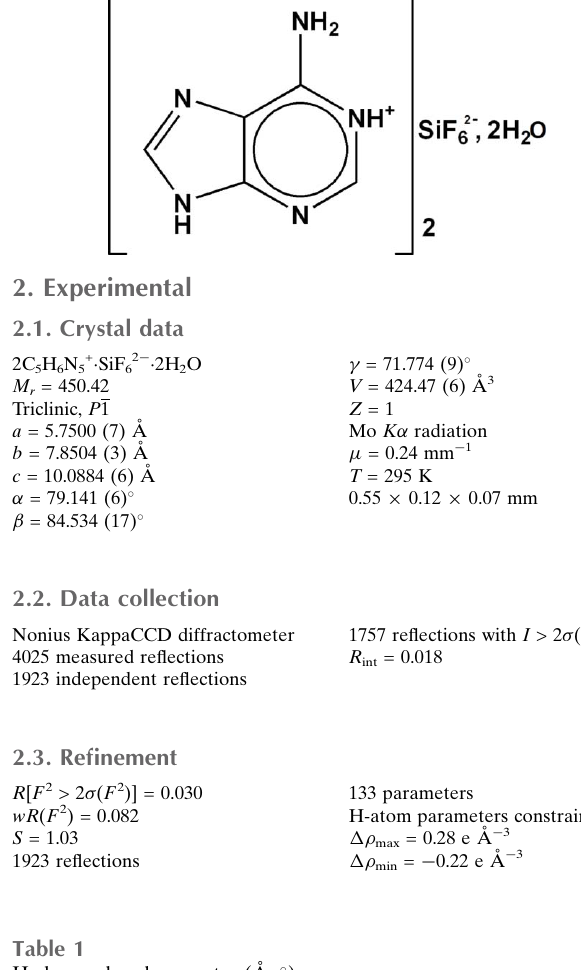
Hydrogen-bond geometry (A˚ , (cid:4)